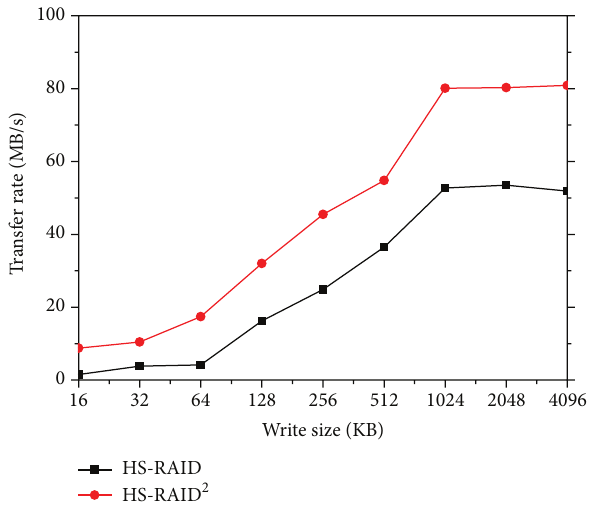
Figure 8: Performance of HS-RAID and HS-RAID 2 (3 disks per